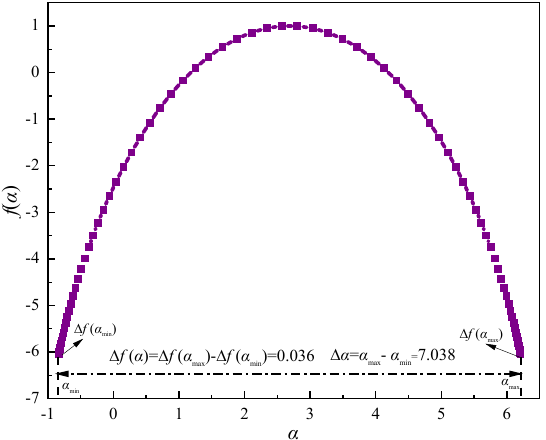
Figure 12. Multifractal spectrum of typical acoustic emission signals.